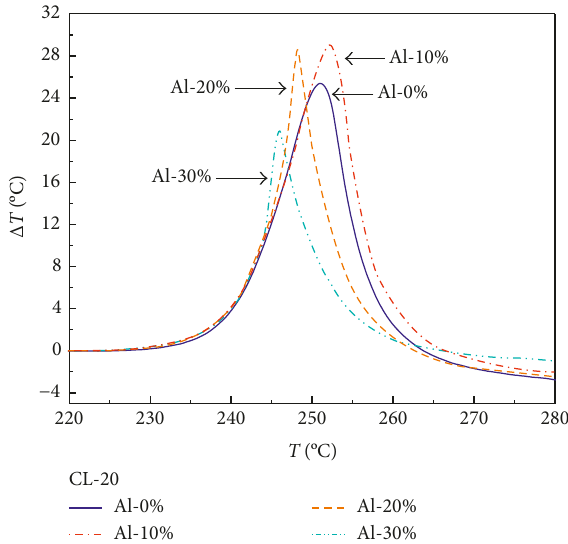
Figure 7: DTA curves of CL-20 with different mass percentages of Al powder.